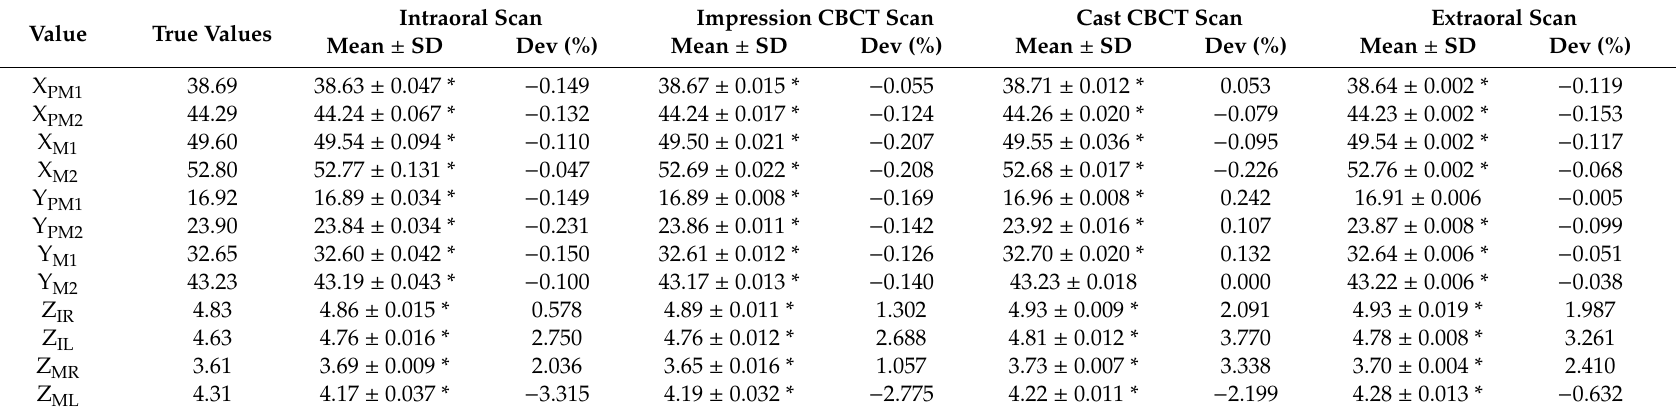
Table 1. Linear measurement values and the percent deviation from the true value according to the individual measurements of respective scanning method (units: